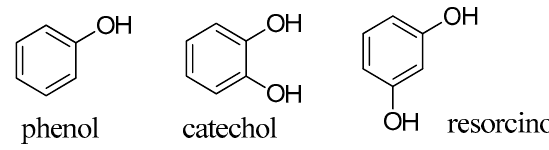
Figure 14. Structures of basic phenol rings: phenol, catechol and resorcinol.